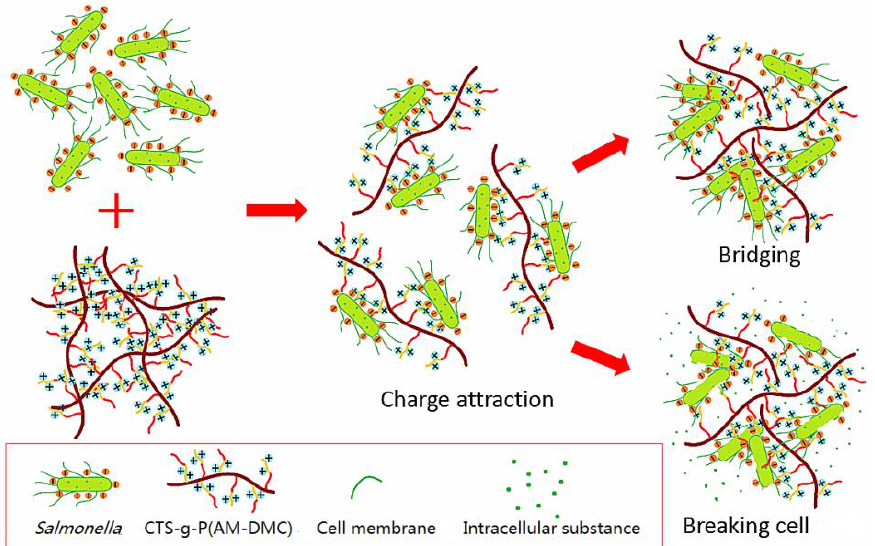
Figure 11. Flocculation and sterilization mechanism of CTS- g -P(AM-DMC).